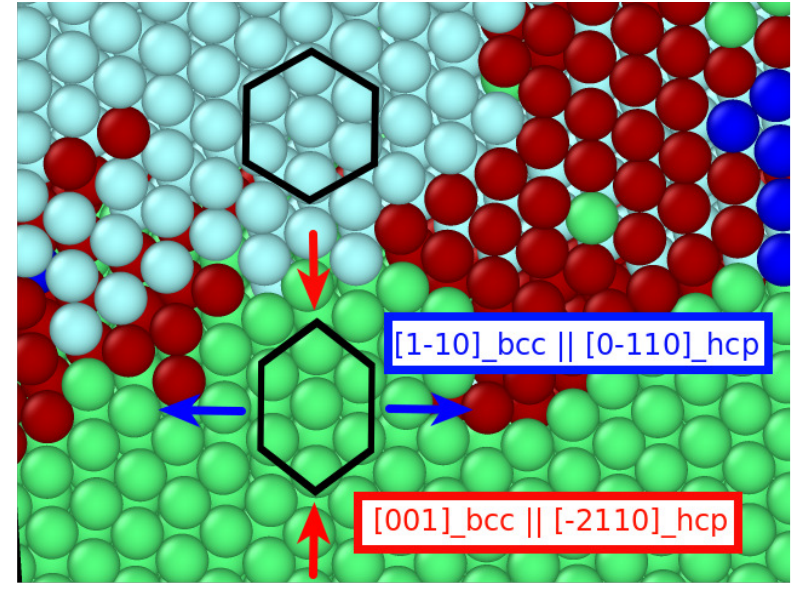
Figure 7. View on the transforming system at a temperature of 671 K, corresponding to Figure 6c. The view direction is perpendicular on a ( 110 ) bcc (cid:107) ( 0001 ) hcp plane. In this plane, the [ 1¯10 ] bcc direction transforms into the [ 0¯110 ] hcp direction by an expansion (blue arrows) The [ 001 ] bcc direction transforms into the [ ¯2110 ] hcp direction by a compression (red arrows). The black hexagons show the transformation from the relevant atoms in the bcc crystal into the hcp unit cell. Atoms are colored as in Figure